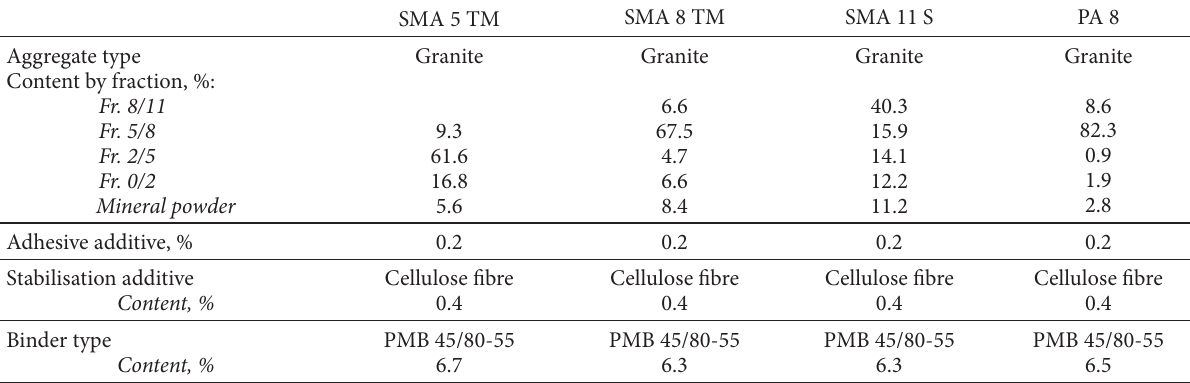
Table 2. Design characteristics of tested asphalt mixtures